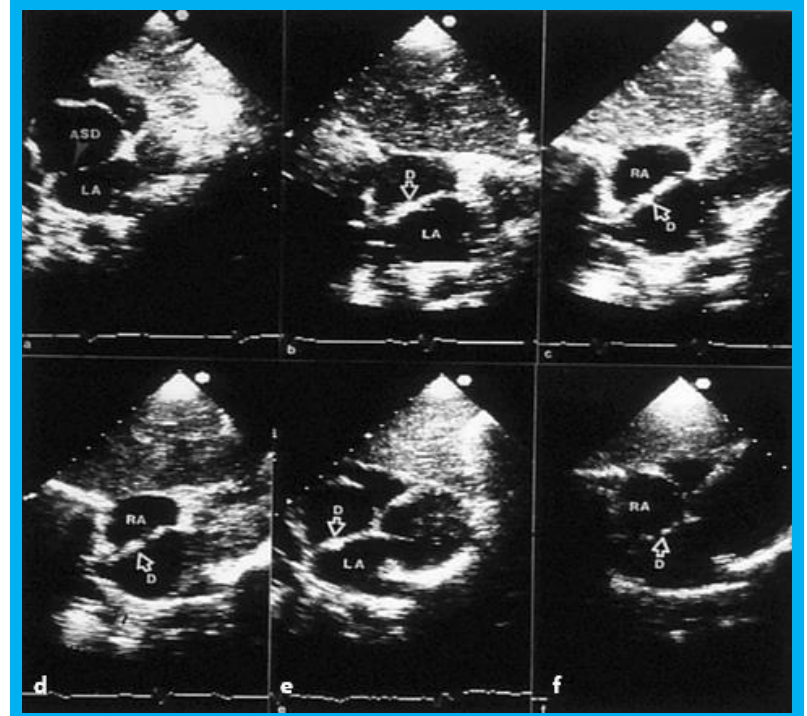
Figure 10. Selected video frames from 2D echo studies in subcostal position of the atrial septum in long-axis view prior to ( a ); immediately after ( b ); and at one ( c ), six ( d ), 12 ( e ), and 24 ( f ) months following atrial septal defect (ASD) closure illustrating the results of transcatheter closure of ASD with buttoned device. Note the position of the device (D) across the ASD ( b – f ) during follow-up, the device appears to be incorporated into the atrial septum. On pulsed and color-Doppler studies concurrent with two-dimensional echo studies, there was no evidence for left over shunt (not shown). LA, left atrium; RA, right atrium. Reproduced from Rao P.S., et al. [9].